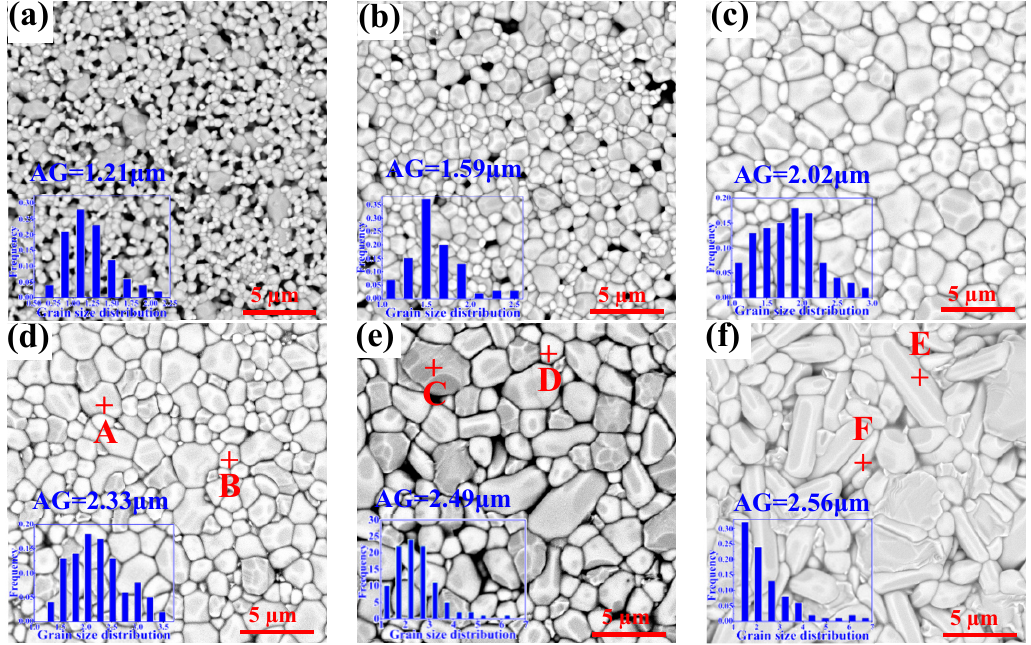
Figure 6. SEM images and grain size distribution (inset figure) of MgCu 2 Nb 2 O 8 ceramics sintered at ( a ) S T = 875 °C, ( b ) S T = 900 °C, ( c ) S T = 925 °C, ( d ) S T = 950 °C, ( e ) S T = 975 °C, and ( f ) S T = 1000 °C.